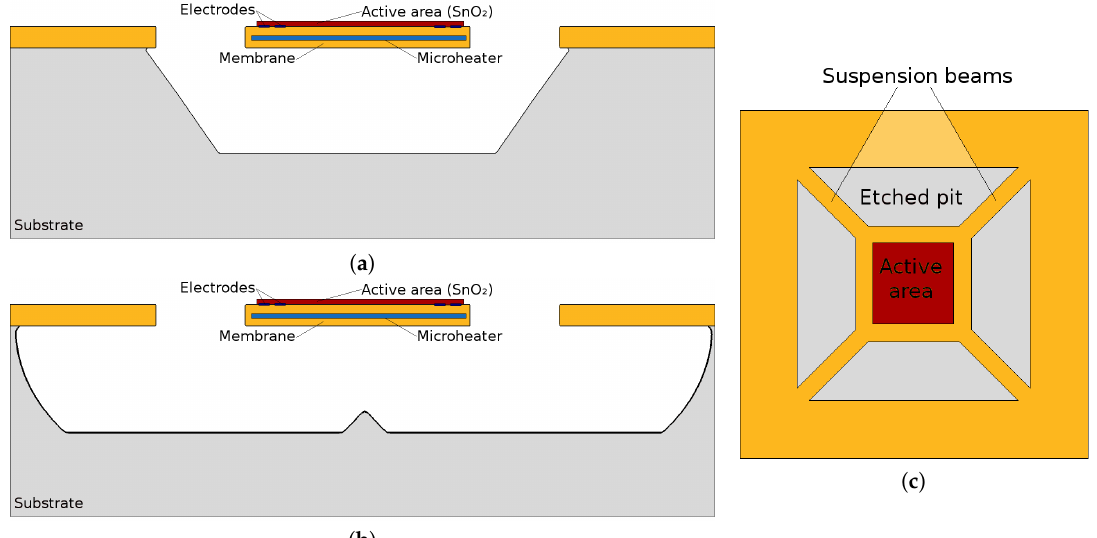
Figure 4. Suspended membrane of an SMO sensor device with a side view shown in ( a , b ) and a top view is given in ( c ). In ( a , b ) wet chemical etching using KOH and dry etching using SF 6 plasma, respectively, are shown, with their differences clearly evident. In ( c ) the top view of the final suspended structure is